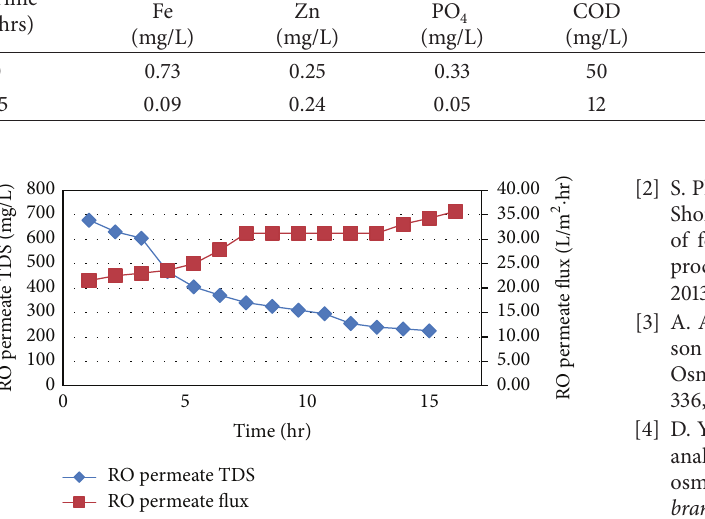
Table 4: Analysis of Ezz Steel treated wastewater and diluted synthetic SW before and after FO/RO continuous process. Time